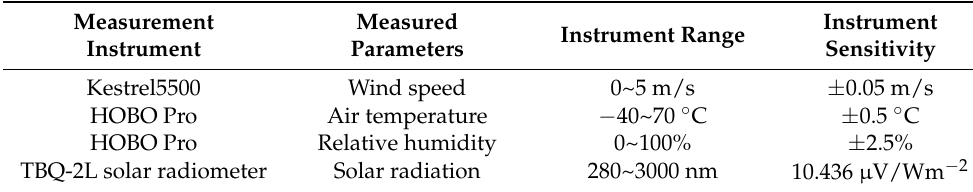
Table 2. Measuring instrument and parameters.